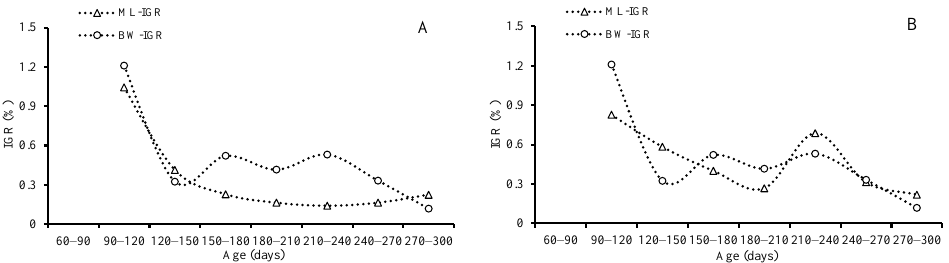
Figure 10. Instantaneous growth rates (IGRs) of mantle length and body weight for S. oualaniensis: ( A ) males, and ( B ) females.